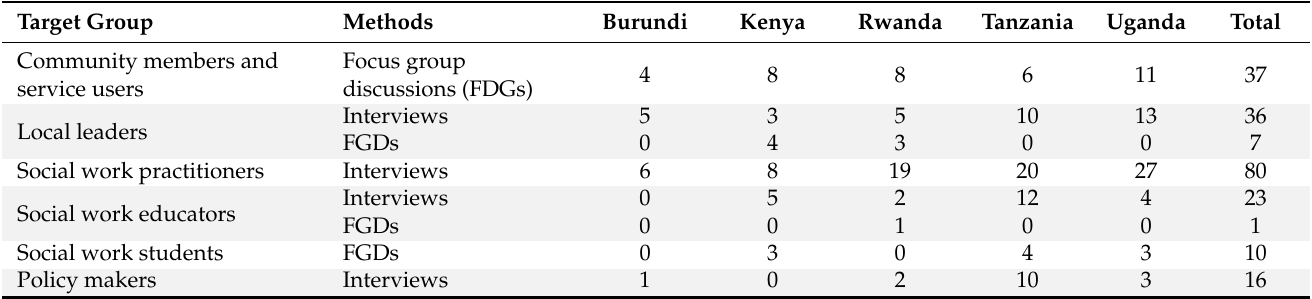
Table 2. Distribution of study